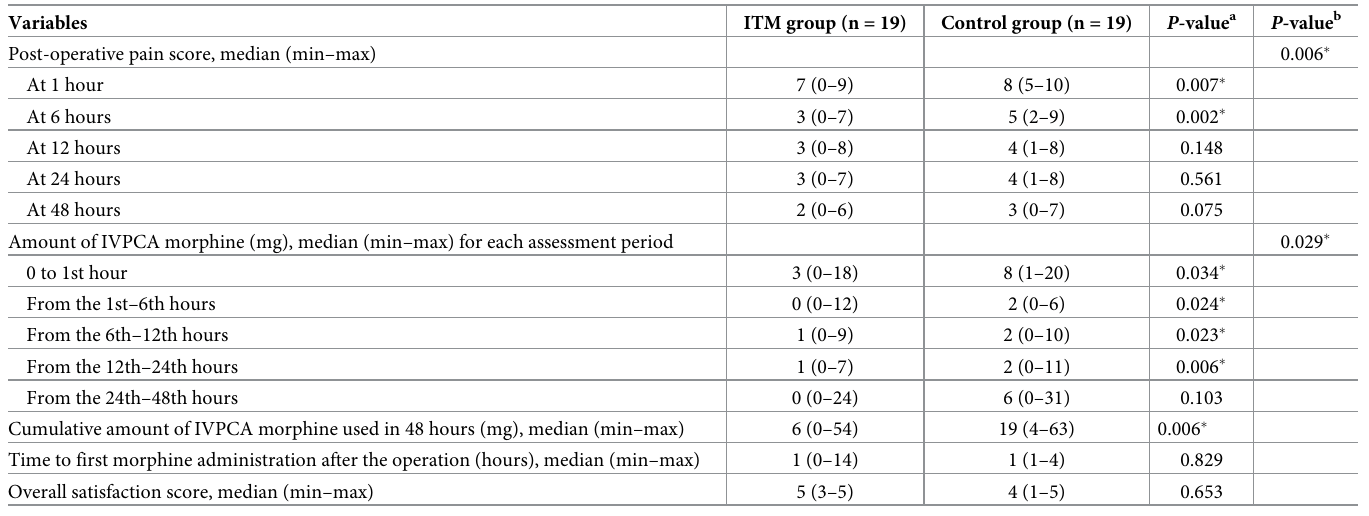
Table 2. Post-operative outcomes (pain, sedation, and satisfaction